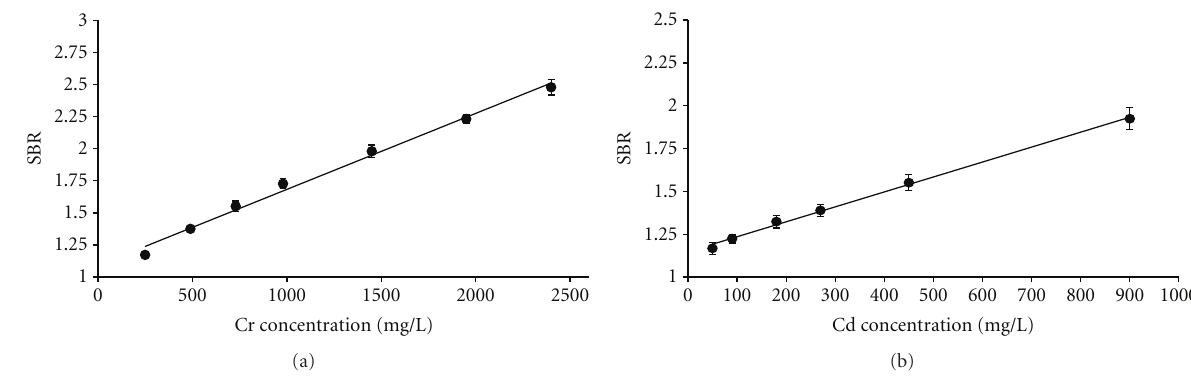
Figure 6: Calibration curve; concentration versus signal intensity (SBR) for Cr (427.481 nm) and Cd (226.502 nm). Error bars denote the 95% CI and are based on replicate (10) measurements.